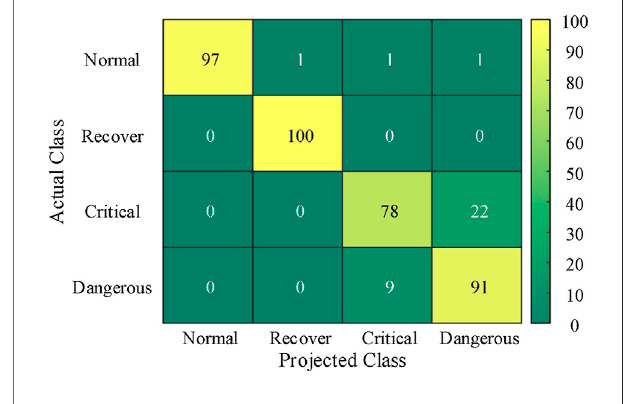
FIGURE 8 | Projection results of